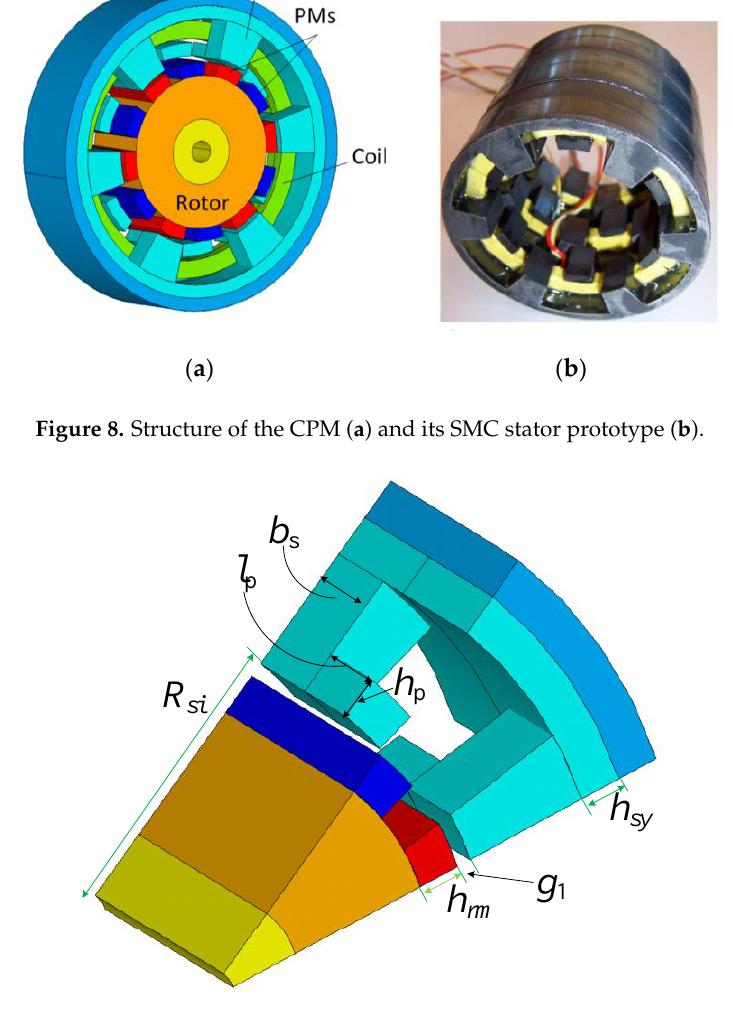
Figure 9. Main dimensions of the CPM. Table 3. Main dimension and design parameters of the CPM prototype.